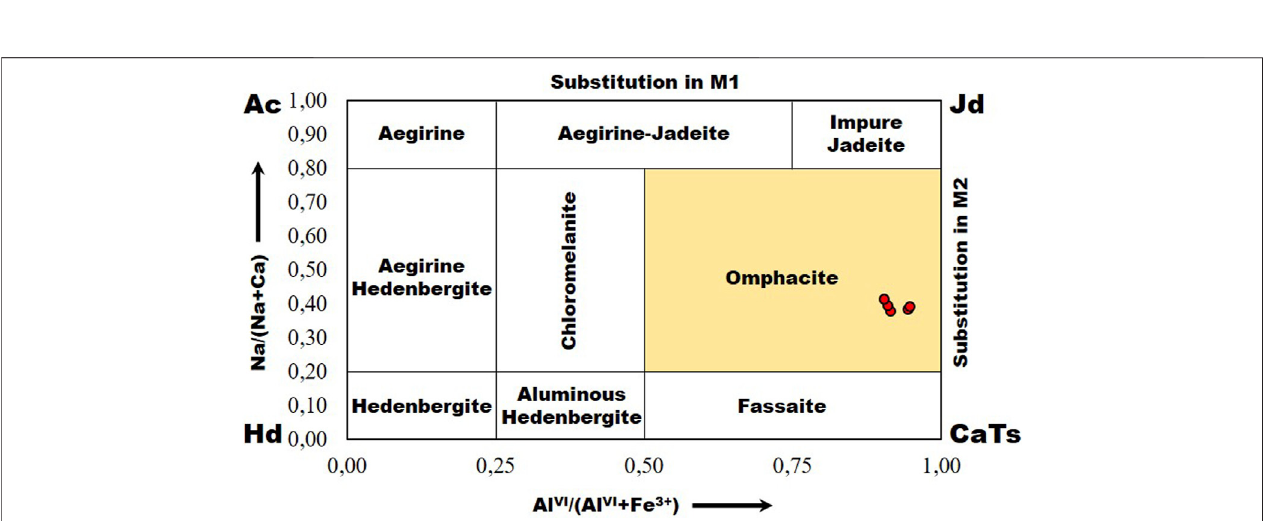
FIGURE 7 | Classi fi cation proposed for alkaline pyroxenes, incorporating the fi eld of omphacite as de fi ned by Clark and Papike (1968). Ac, acmite; Hd, hedenbergite; Jd, jadeite; CaTs, Ca tschermakite.